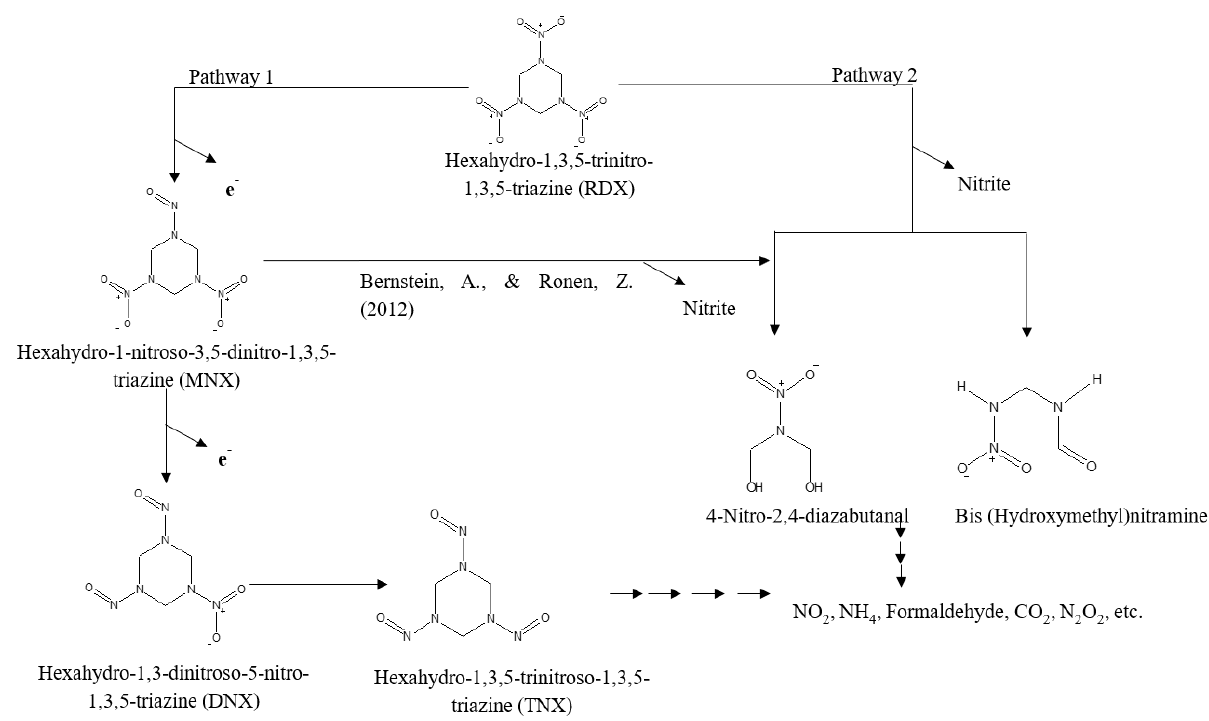
Figure 7. Proposed pathways for the biodegradation of RDX with Bacillus toyonensis and Paenibacillus dendritiformis .